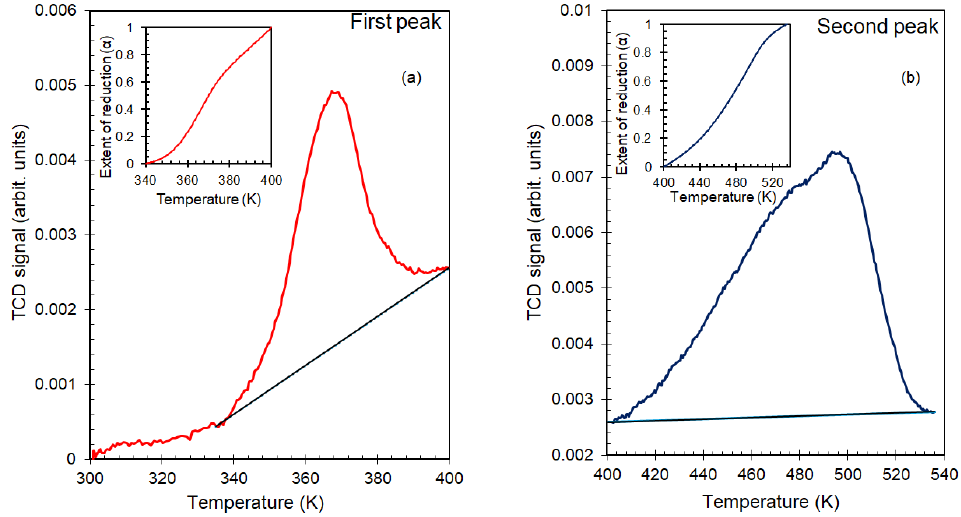
Figure 4. Selected TCD signals during TPR of 3.5% wt.% IrO 2 /TiO 2 (anatase, BET surface area = 55 m 2 /g) and their respective α (extent of reduction, in the insets) for the first ( a ) and second ( b ) reduction